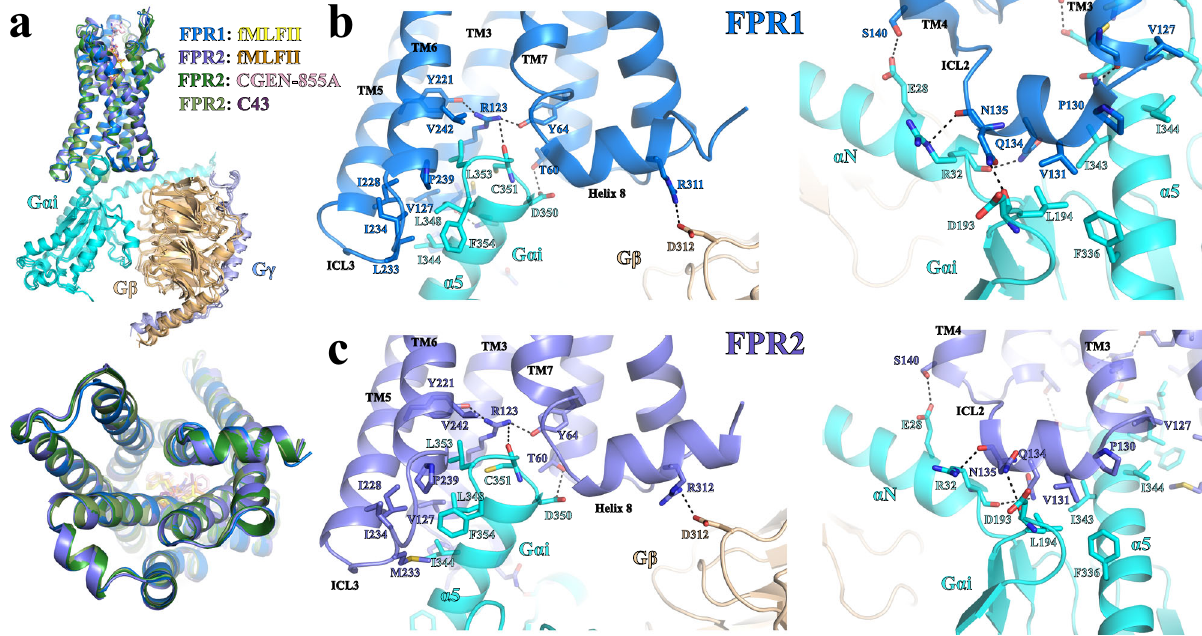
Fig. 2 Conserved G i -coupling mode for FPR1 and FPR2. a Structural superimposition of the FPR1- and FPR2-G i complexes based on the alignment of FPR1 and FPR2. The lower panel shows the structural alignment of the cytoplasmic regions of FPR1 and FPR2 in four structures. b , c Detailed interactions between the two FPRs and G i viewed from two angles. FPR1 and FPR2 are colored in slate and blue, respectively. G α i , G β , and G γ are colored in cyan, sand, and light blue, respectively. Hydrogen bonds are shown as black dashed receptor residues Y64 2.43 and Y221 5.58 and the main-chain cluster with nearby residues of FPR1 and FPR2 including the ICL3 residue M233 in FPR2 and L233 in FPR1 (Fig. 2b, c). In carbonyl of C351 of G α (Fig. 2b, c). Besides the cytoplasmic cavities, ICL2s in FPR1 and FPR2 is also involved in direct both receptors, R123 3.50 (superscripts represent Ballesteros- interactions with G α i . The ICL2 residues P130 and V131 in both Weinstein numbering 42 ) in the conserved DR 3.50 Y/F/C motif mediates a hydrogen bond network with the side chains of receptors form another hydrophobic cluster with G α i residues